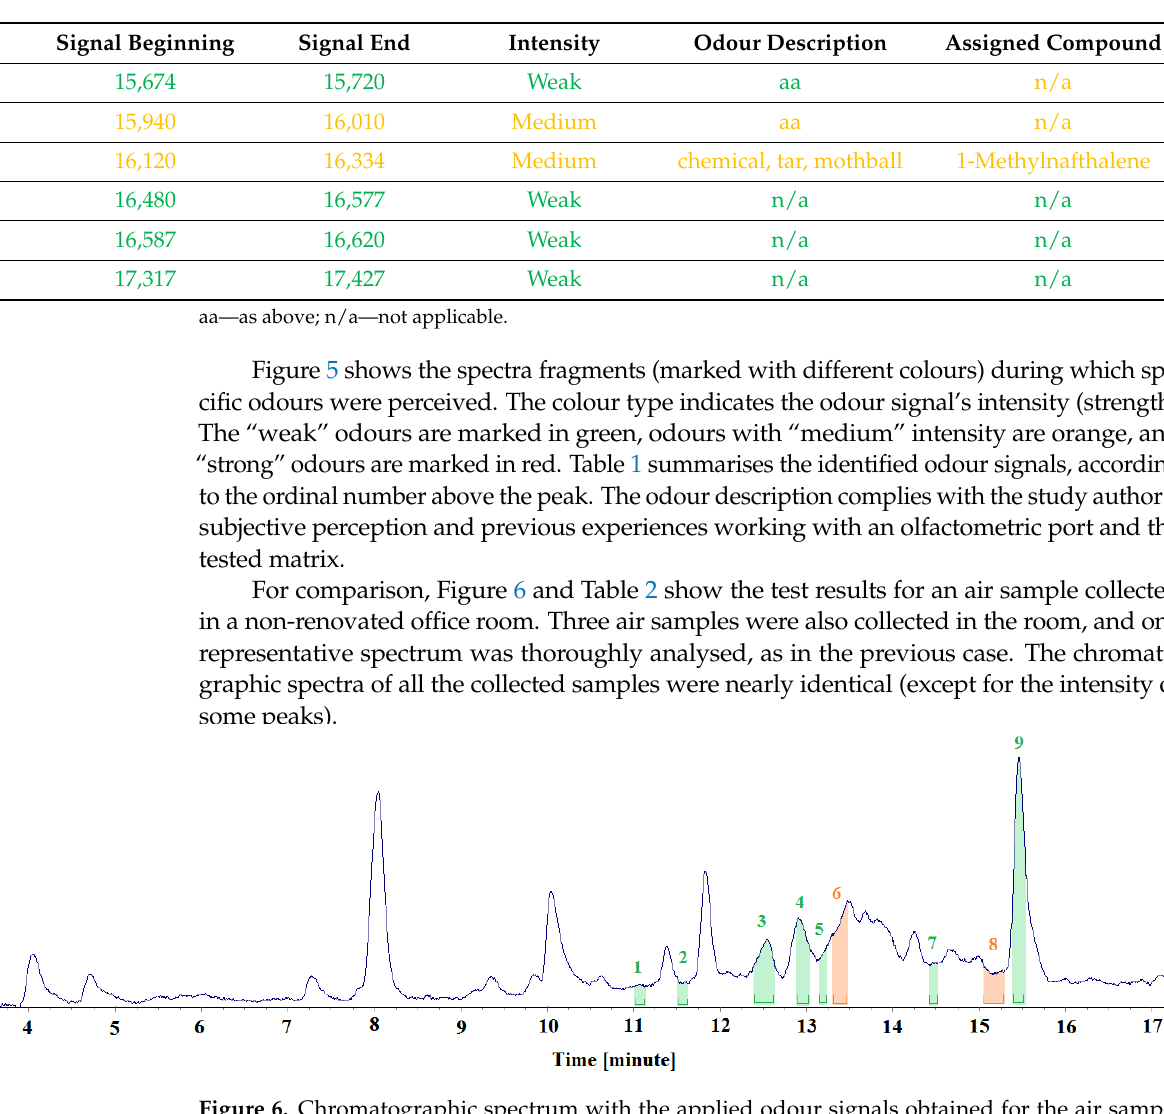
Table 2. Identification of the signals obtained for the air sample collected from the non-renovated office room.